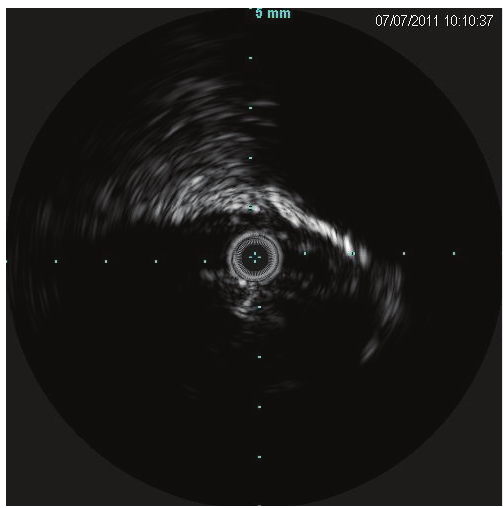
Figure 1: Initial diagnostic venography at presentation prior to thrombolysis; left iliac vein.